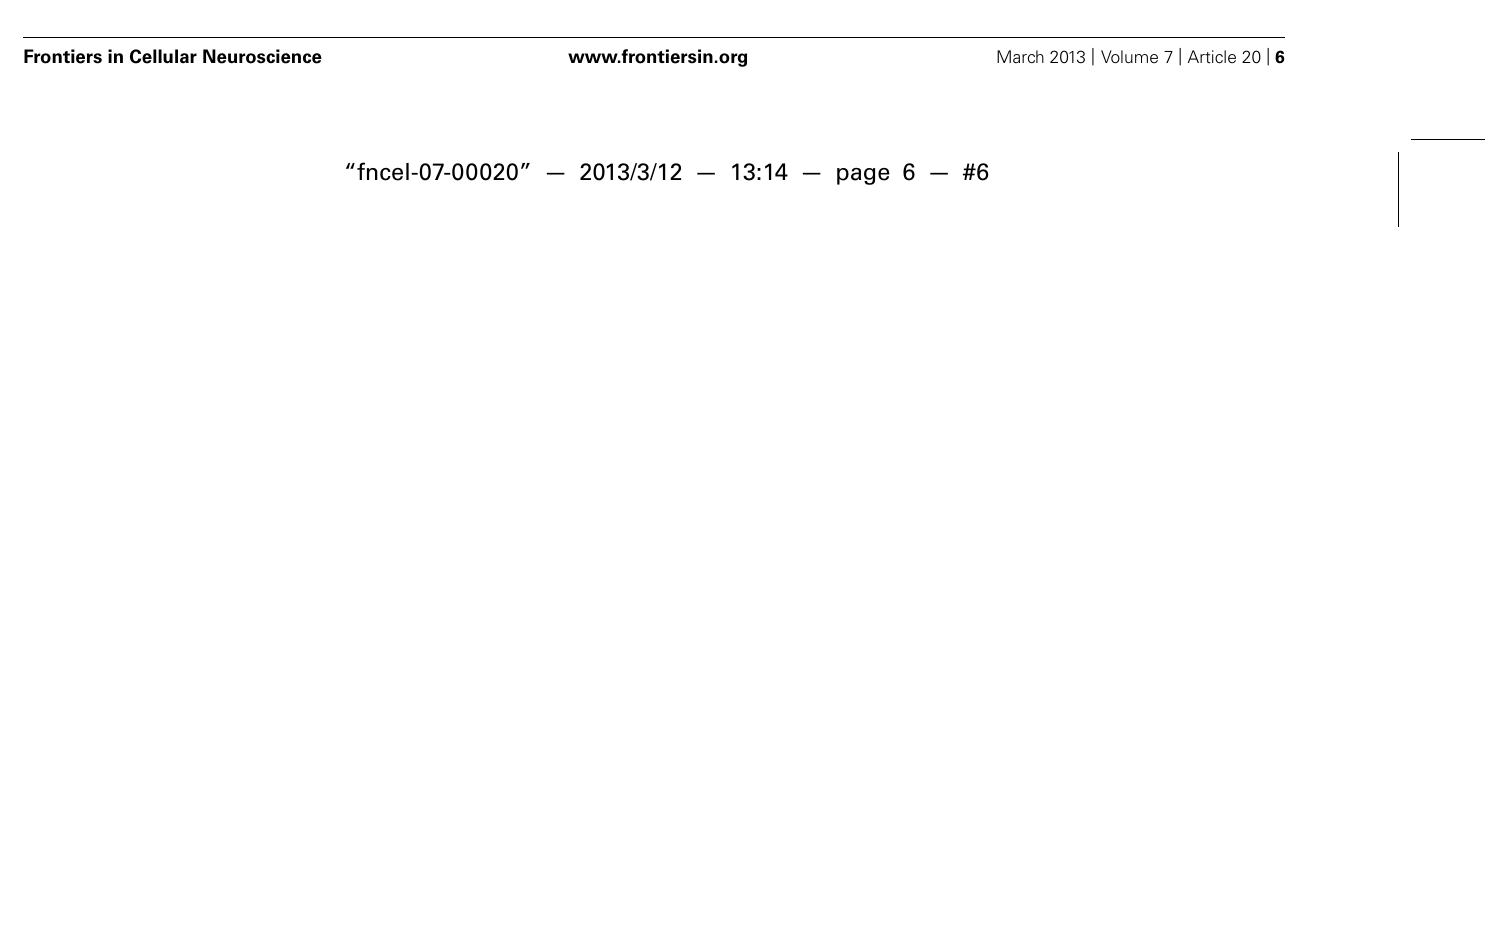
superposition of 20 sweeps.The time window in which MUA response was calculated is outlined by the dashed line. Corresponding peristimulus time histograms of spikes normalized to 100 sweeps are shown below each trace. Both excitatory (P2) and inhibitory (P5) responses were completely suppressed by the GABA(A) receptor antagonist bicuculline